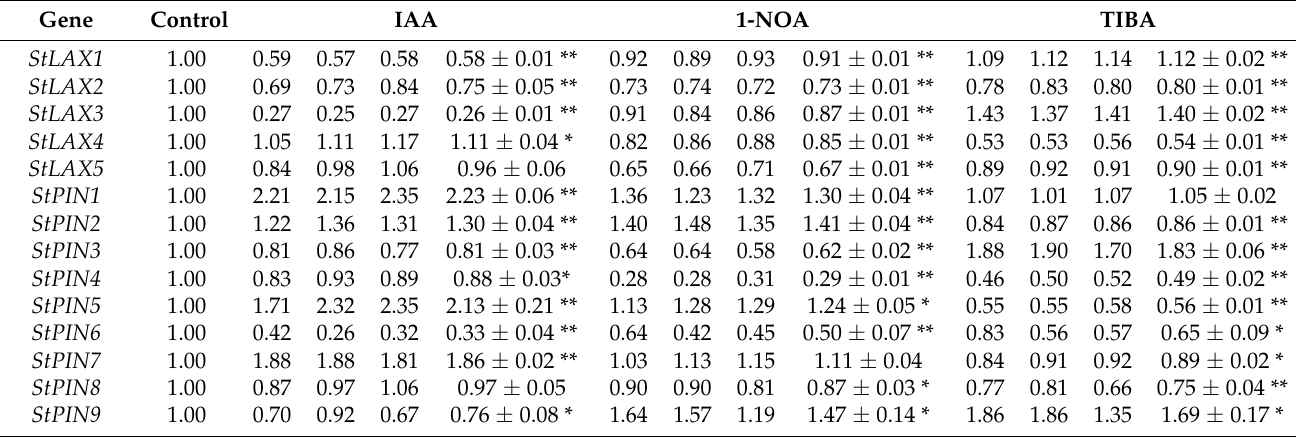
Table A8. Raw data of auxin transporter genes under IAA and auxin transport inhibitors (PATIs) treatments. Gene Control TIBA